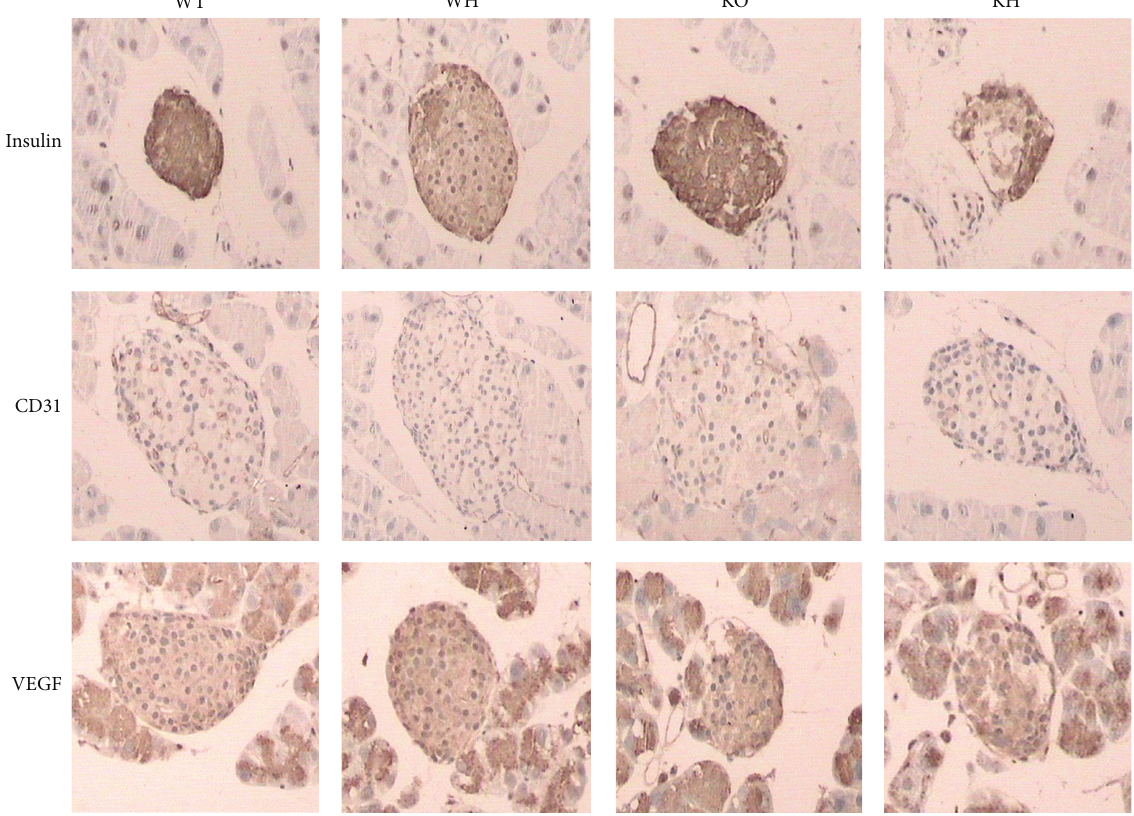
Figure 5: Immunohistochemistry. WT: wildtype mice; WH: wildtype mice with high-fat diet; KO: ACE2 knockout mice; KH: ACE2 KO mice with high-fat diet. VEGF: vascular endothelial growth